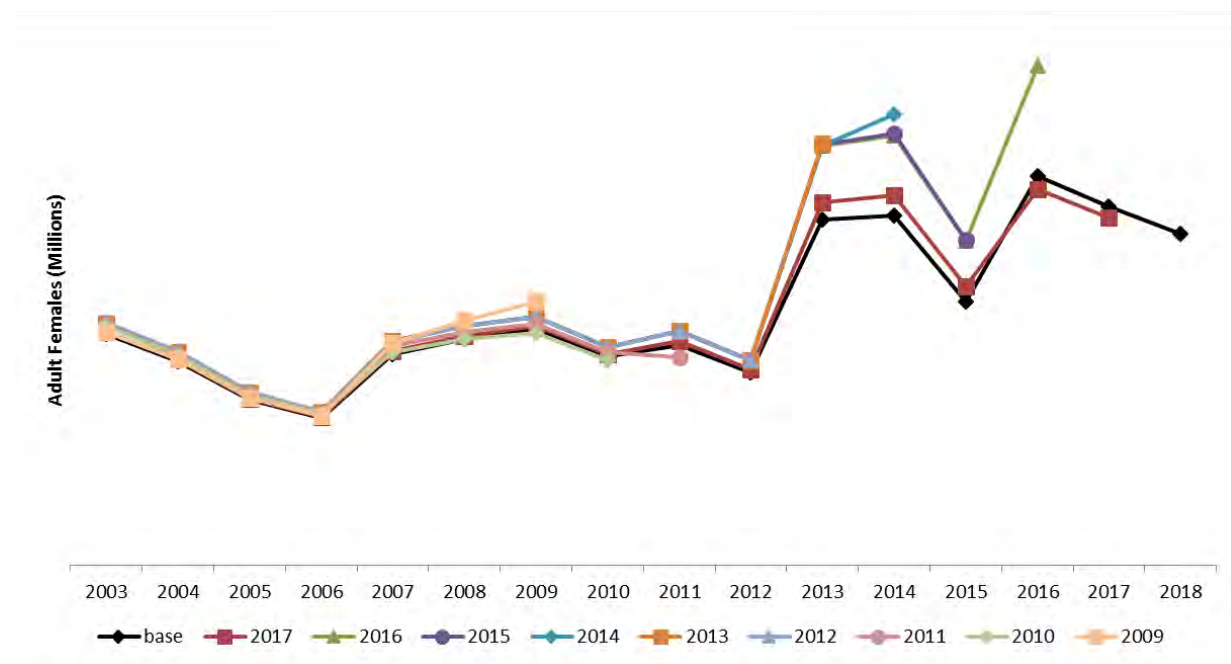
Figure 112. Retrospective peel of estimated total adult female abundance to 2009. Y-axis values have been removed due to CONFIDENTIAL data. [Figure Removed Due to CONFIDENTIAL Data]